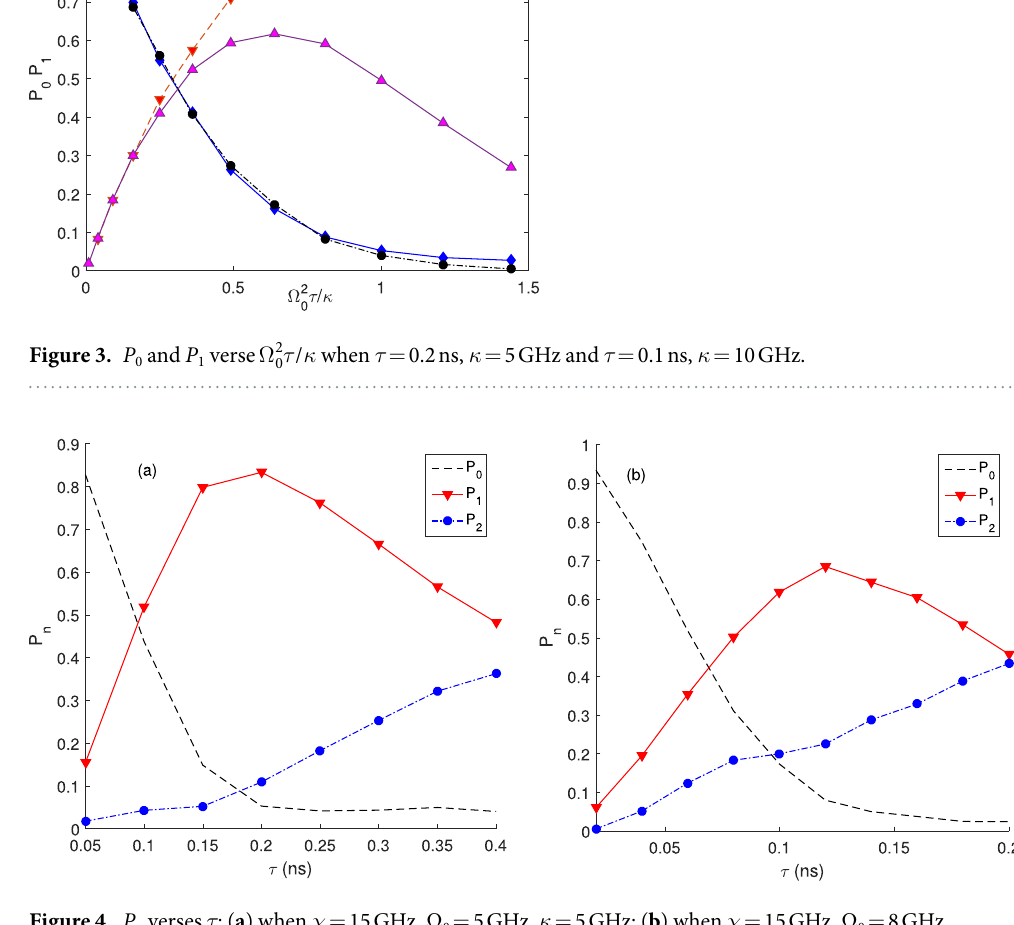
Figure 4. P n verses τ : ( a ) when χ = 15 GHz, Ω 0 = 5 GHz, κ = 5 GHz; ( b ) when χ = 15 GHz, Ω 0 = 8 GHz, κ = 10 GHz.